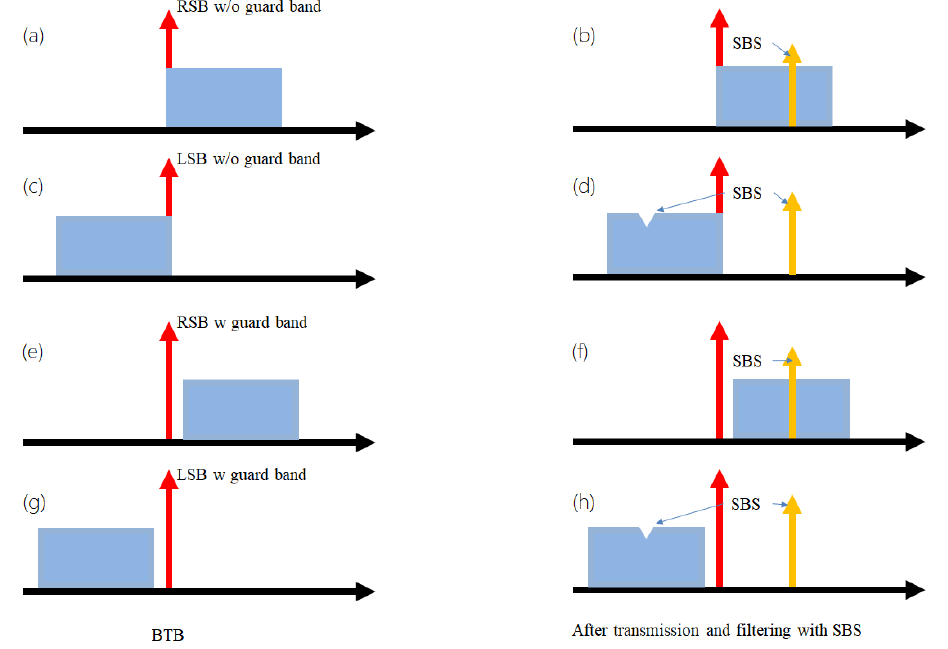
Figure 1. SBS induced nonlinear distortion for SSB signals. ( a ) RSB without guard band; ( b ) RSB without guard band after SBS distortion; ( c ) LSB without guard band; ( d ) LSB without guard band after SBS distortion; ( e ) RSB with guard band; ( f ) RSB with guard band after SBS distortion; ( g ) LSB with guard band; ( h ) LSB with guard band after SBS distortion.